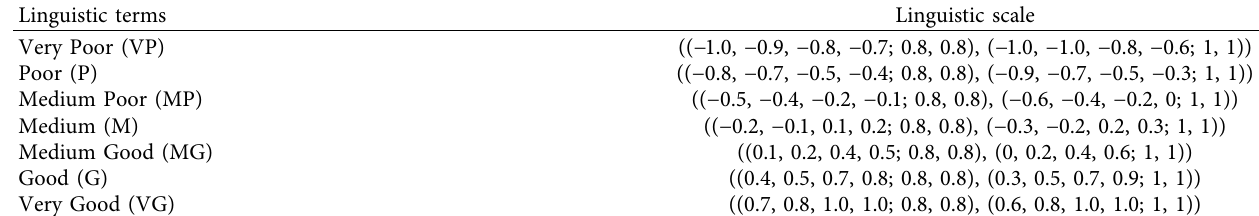
Table 1: Linguistic scale of restriction for the extended